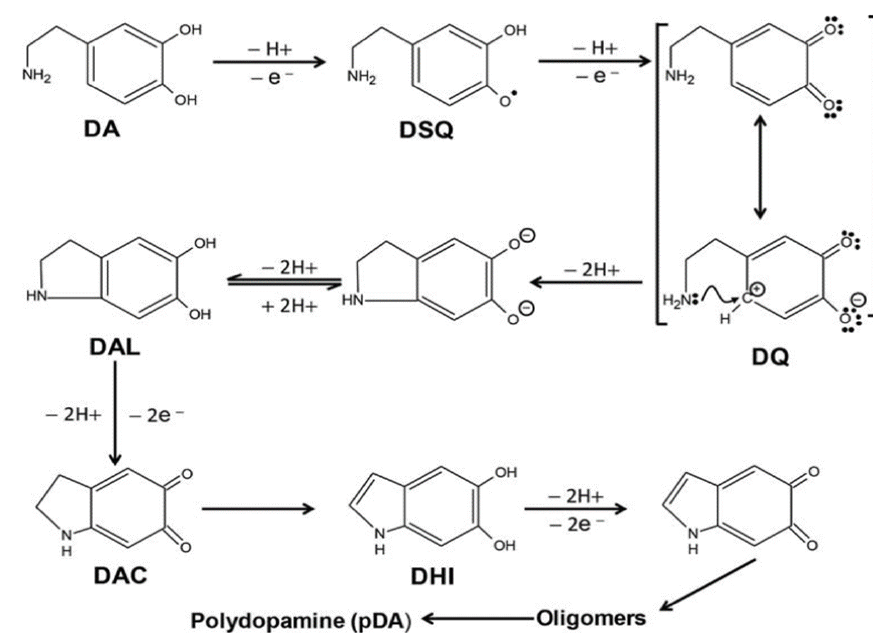
Figure 1. Steps involving autooxidation of dopamine to polydopamine in alkaline pH [15].